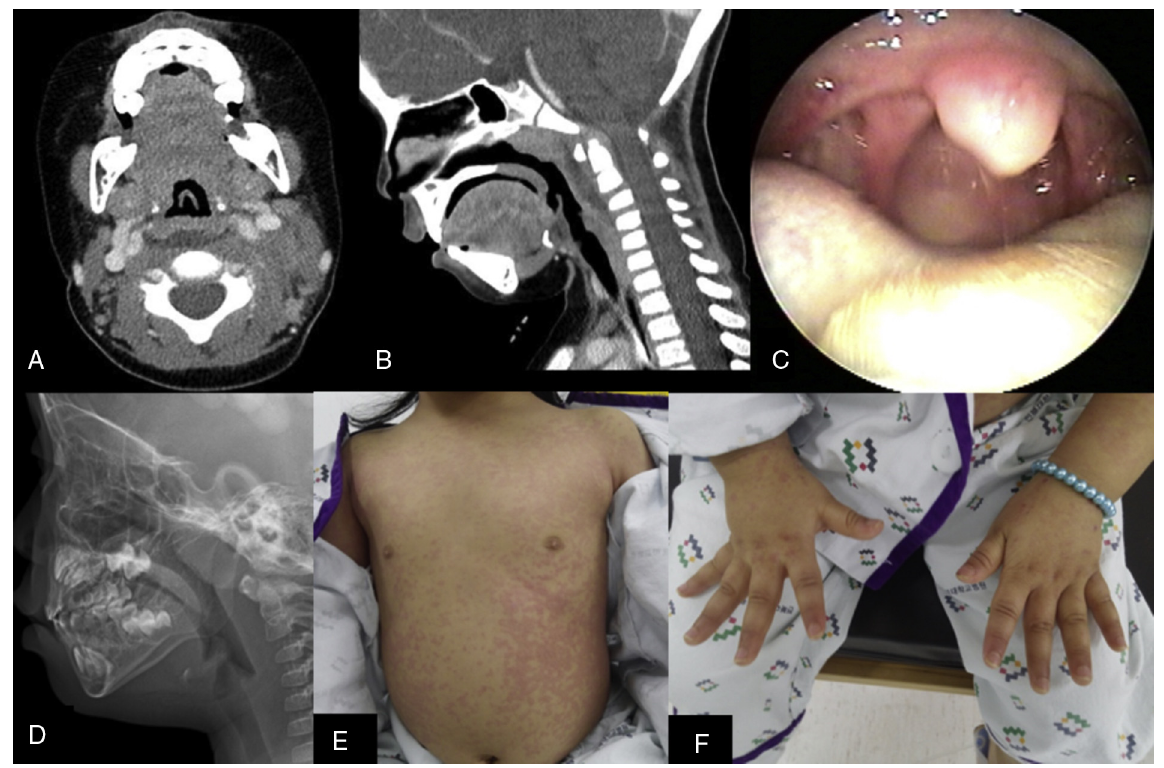
Figure 1 (A) Axial CT view revealed 4 cm × 1 cm hypodense area in the retropharyngeal space. (B) Coronal CT showed 1 cm × 4 cm sized hypodense area in the retropharyngeal space, from C2 level to C5 level. (C) Mild injected throat and grade II tonsil was noted on the endoscopy. Swelling of post pharyngeal wall was also identified. (D) Simple neck X-ray revealed mild swelling of retropharyngeal soft tissue and no interval change compared with previous film. (E) Polymorphous erythematous rash appeared on the anterior and posterior trunk. (F) Erythematous rash and edema appeared on both hands.